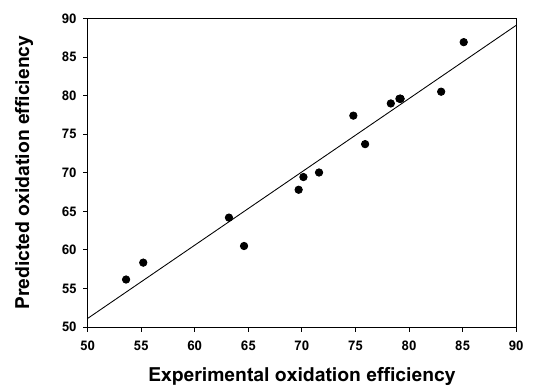
Figure 4. Comparison of predicted and experimental oxidation efficiencies.